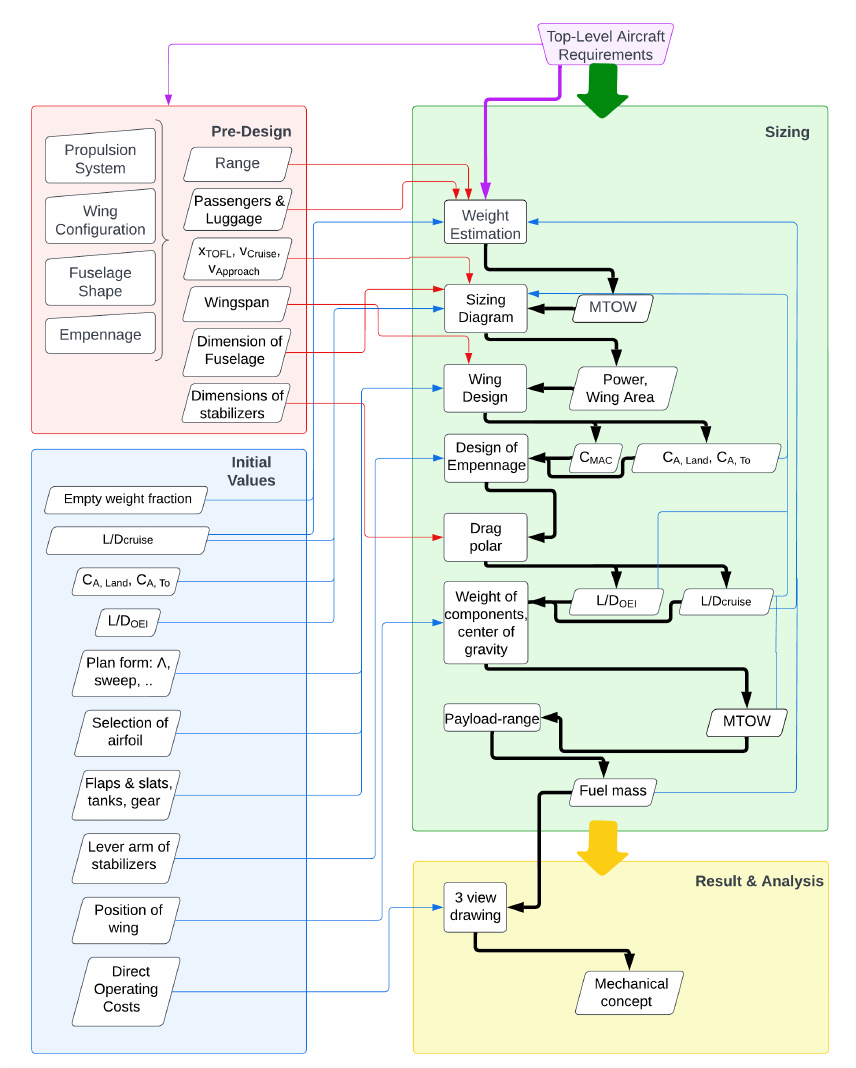
Figure 1. Schematic representation of the sizing code with the pre-design in red, the initial values in blue, the sizing process in green and the results and analysis in